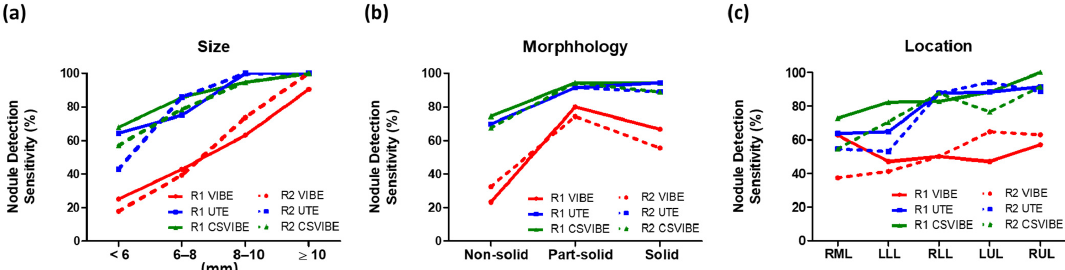
Figure 3. Nodule detection sensitivity for MRI categorized by ( a ) nodule diameter, ( b ) nodule morphology, and ( c ) location, as measured using CT. The nodule detection rate for spiral UTE and CS-VIBE sequences reached 95% when nodule size was >8 mm and reached 100% when nodule size was >10 mm; 90% detection was achieved when nodules possessed a part-solid or solid morphology for all sizes and improved in LLL and RML in both spiral UTE and CS-VIBE images. Abbreviations: MRI: magnetic resonance imaging; R1: reader 1; R2: reader 2; CS: compressed sensing; VIBE: volumetric interpolated breath-hold examination; UTE: ultrashort echo time; LML: left middle lobe; RML: right middle lobe.